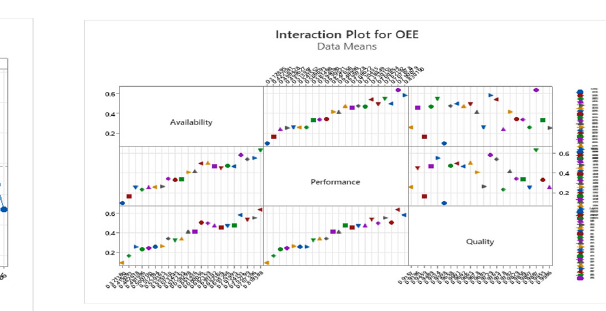
Fig. 3. Main Effects Plot Fig. 4. Interaction Plot for